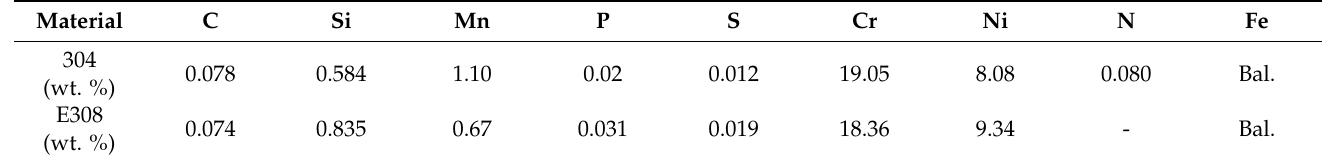
Table 1. Chemical compositions of the base metal and welding wire (data from [29,30]).